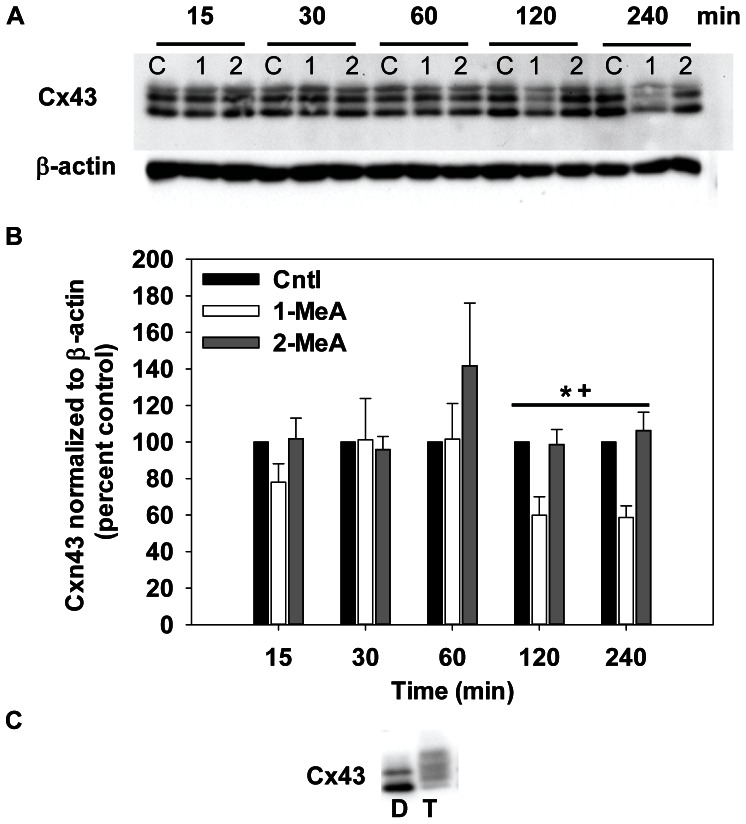
Decreases in Cx43 protein expression following 1-MeA treatment but not 2-MeA treatment.(A) Immunoblot of Cx43 for 15 min to 4 h after treatment. (B) Densitometric analysis of Cx43 normalized to β-actin, represented as percent control. Concentrations used: 75 µM 1-MeA and 75 µM 2-MeA. Mean ± SEM presented with n = 3 per study, replicated 3 times. 1-MeA, 1-methylanthracene; 2-MeA, 2-methylanthracene; Cntl, CH3CN vehicle control. *p<0.05 compared to control; +p<0.05 compared to 2-MeA treated cells at the same time point. (C) Positive control using T (TPA; 50 nM, 60 min) or D (DMSO; negative control) for activation of Cx43.